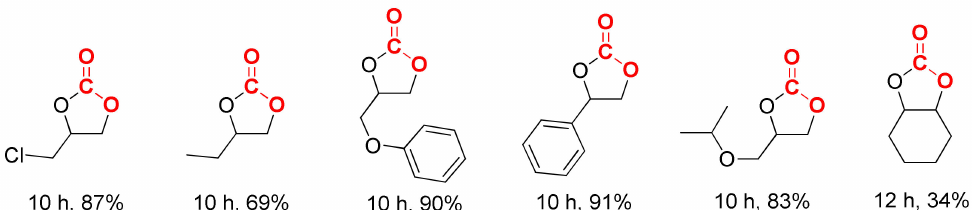
Figure 4. Reaction conditions: substrate (20 mmol), an initial pressure of 3 MPa CO 2 , substrate/catalyst = 5000, Iq-POC (4.8 mg, 0.004 mmol), ZnBr 2 (9 mg, 0.04 mmol), 120 ◦ C. The selectivities of all the results were